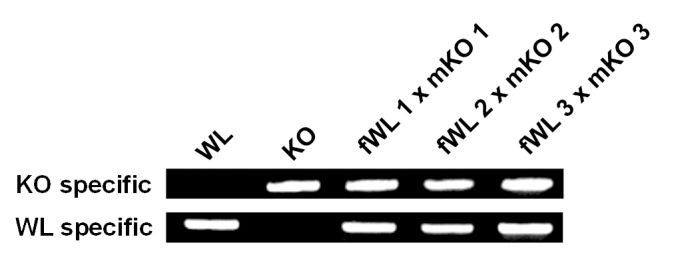
Confirmation of hybrid embryos (Hamburger and Hamilton stage 4) from crosses between female White Leghorn (fWL) and male Korean Oge (mKO) using breed-specific primers.WL, White Leghorn control; KO, Korean Oge control.